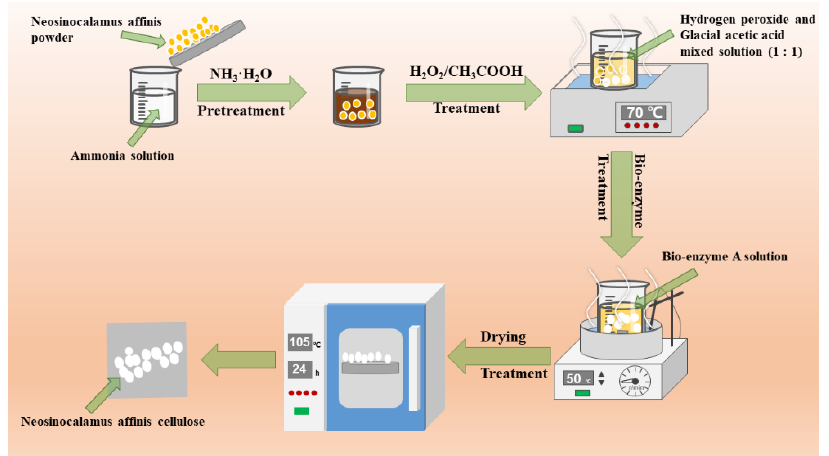
Figure 1. Flowchart of cellulose extraction.